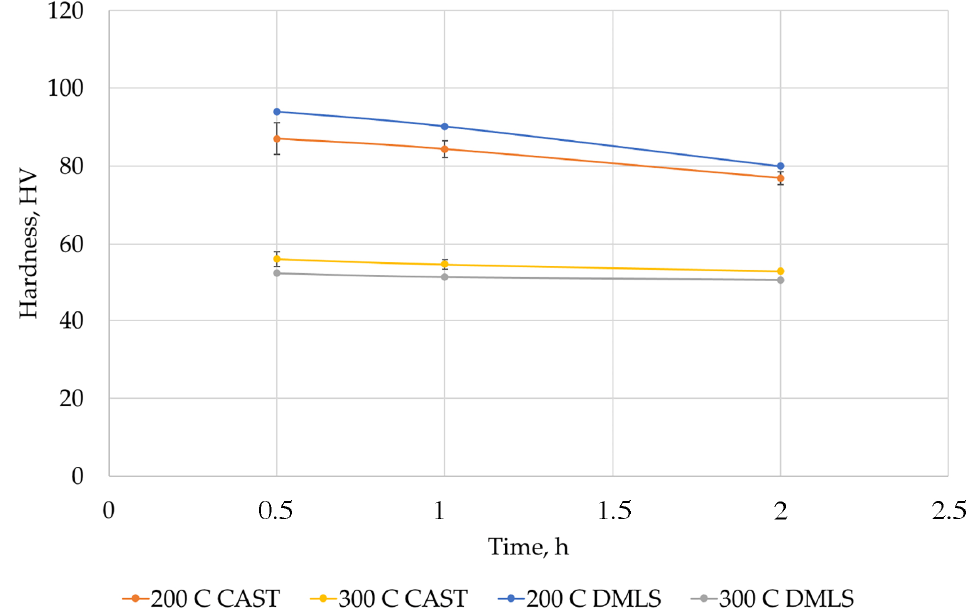
Figure 17. Hardness distribution for cast and printed samples depending on the ageing time and temperature.